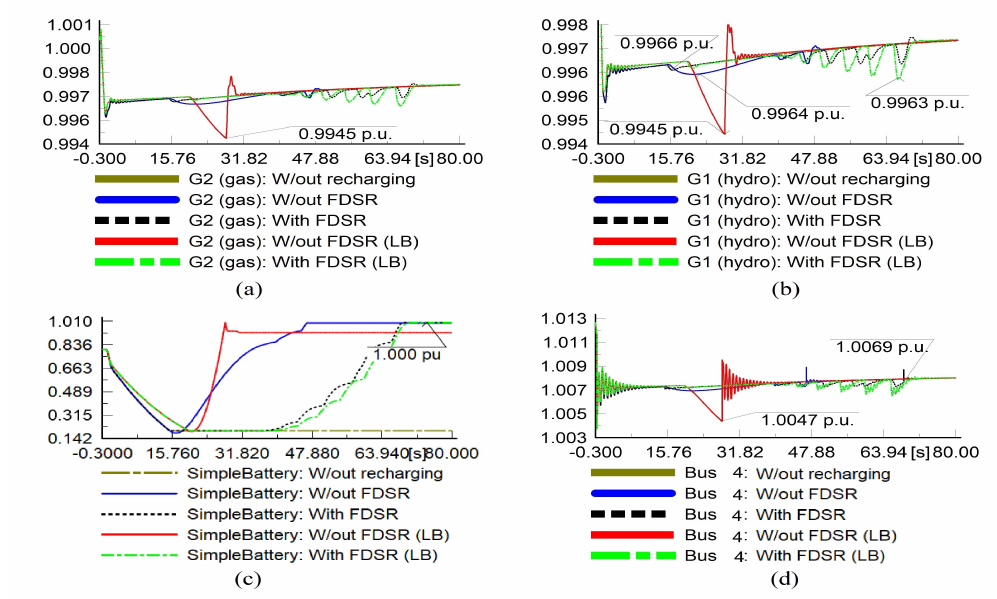
Figure 13. Generator frequency ( a , b ) and battery SOC ( c ) and bus voltage ( d ) with the SOC recharging strategy. FDSR, frequency-dependent SOC recovery; LB, large